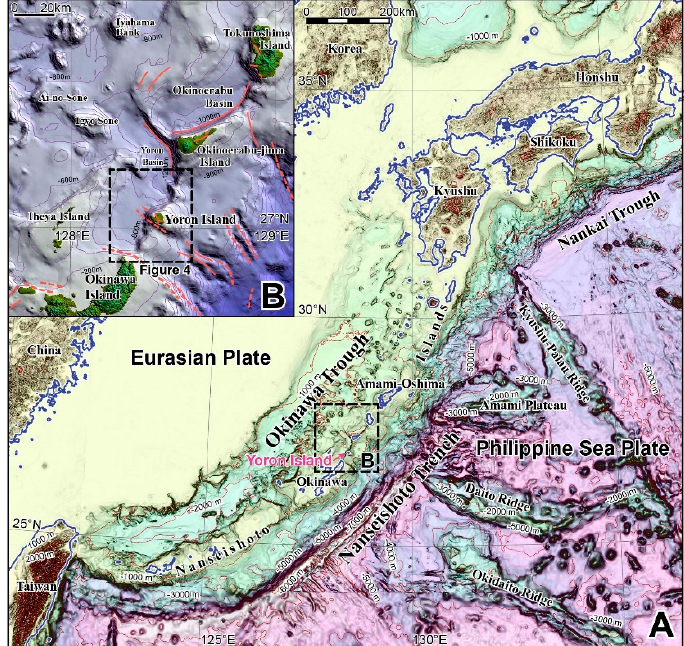
Figure 1. Topography along the Nanseishoto (Ryukyu) trench ( A ) and around the study area ( B ). Shaded relief maps overlain by contour maps use a 500-m mesh DEM (J-EGG500) from the Japanese Coast Gard (JCG), a 1-degree-mesh DEM (ETOPO 1) provided by the National Center for Environmental Information (U.S.A), and on-land SRTM-3 data provided by the USGS. Red lines in ( B ) are indicated the active fault lines after [15].